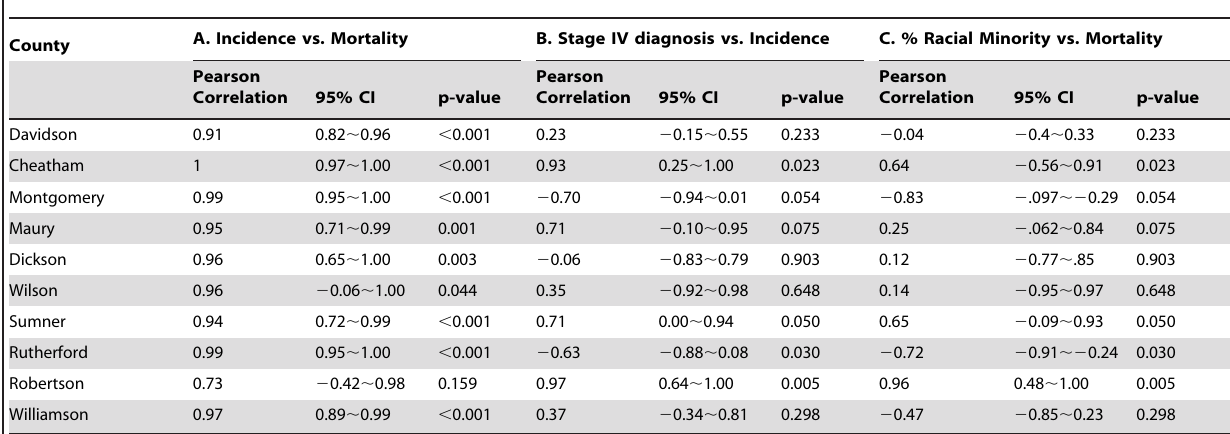
Table 5. Correlation between incidence rate and mortality rate (A), incidence rate and percentage of patients with Stage IV breast cancer (B), and percentage of the female population that is non-white and breast cancer mortality (C) in Middle Tennessee